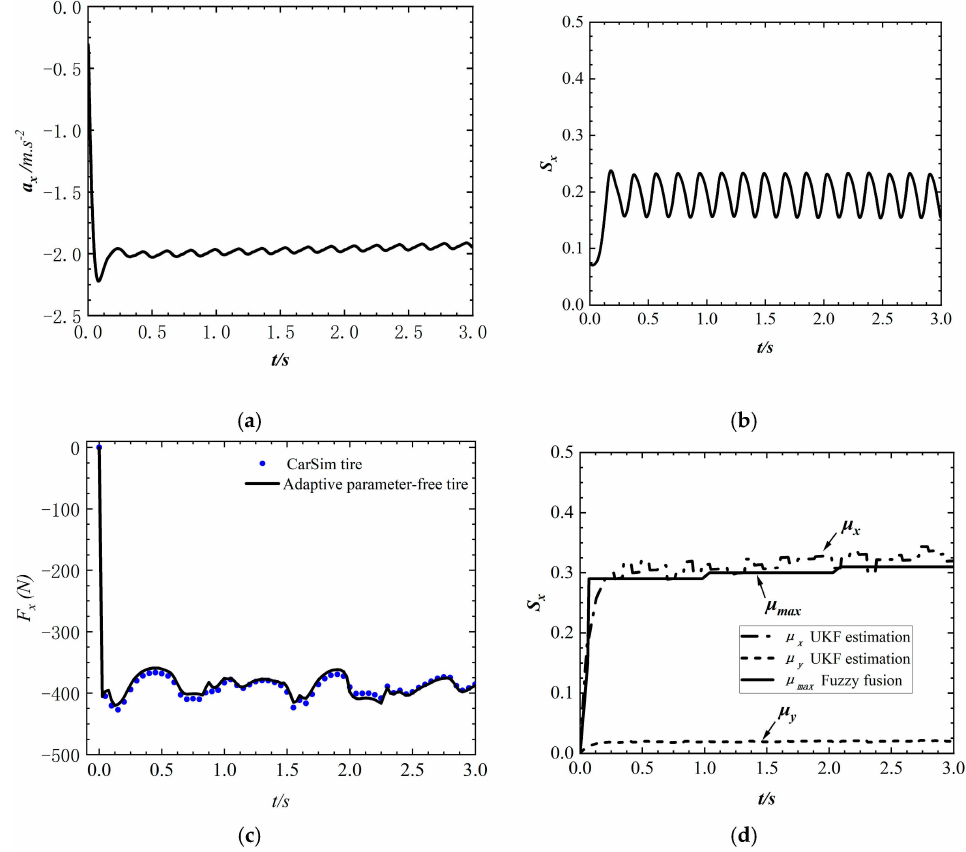
Figure 12. Simulation results under linear braking conditions. ( a ) Longitudinal acceleration. ( b ) Lon- gitudinal slip rate. ( c ) Longitudinal force contrast curve. ( d ) Estimated results of pavement adhe- sion